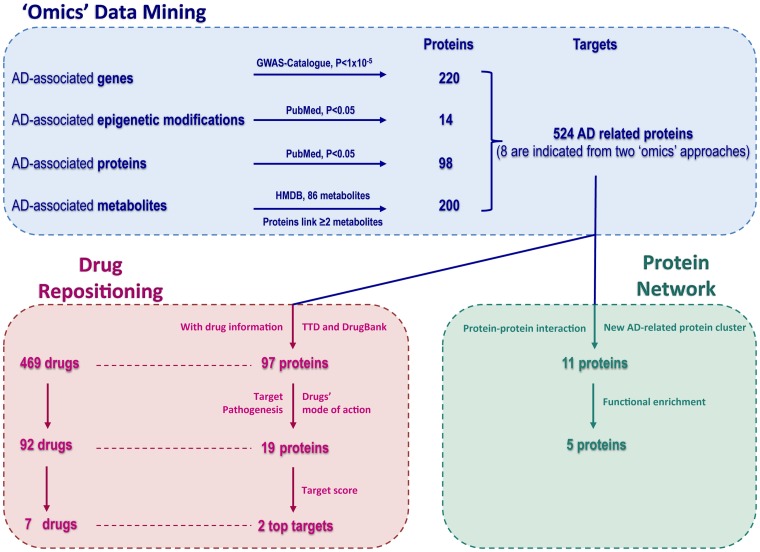
Flow-chart of the drug repositioning strategy for AD based on ‘omics’ data mining.We searched the GWAS Catalogue, PubMed, and HMDB database, and extracted 244 genetic variations, 14 epigenetic modifications, 98 proteins and 86 metabolites associated with AD. We also extracted 1179 protein-metabolite interactions based on the HMDB database and found 200 proteins linked to ≥2 AD associated metabolites. In total, we shortlisted 524 AD-related proteins, 8 of which were revealed by 2 ‘omics’ approaches. By using the TTD and DrugBank database, we extracted information on drugs, targets and the drugs’ mode of action. Considering AD pathogenesis together with the drugs’ mode of action, we found 19 targets of 92 drugs with anti-AD indication that may be repurposed. We then scored these targets and found CD33 and MIF to be the two highest ranked targets. A protein-protein interaction analysis of 524 AD-related proteins detected a novel network of 11 proteins with CAD as a hub protein (functional enrichment analysis revealed that 5 of these 11 proteins are involved in the “Alanine, Aspartate and Glutamate Metabolism” pathway presented in Fig 3).